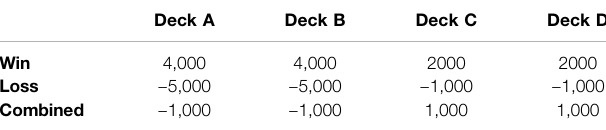
TABLE 2 | Overall win and loss for each IGT deck. Values are in